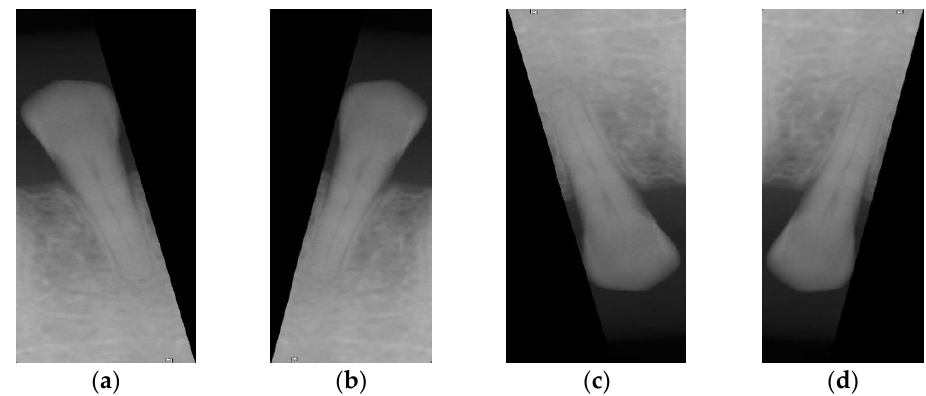
Figure 6. Image after standardization. ( a ) Original image, ( b ) horizontal flip, ( c ) vertical flip, ( d ) vertical and horizontal flip.